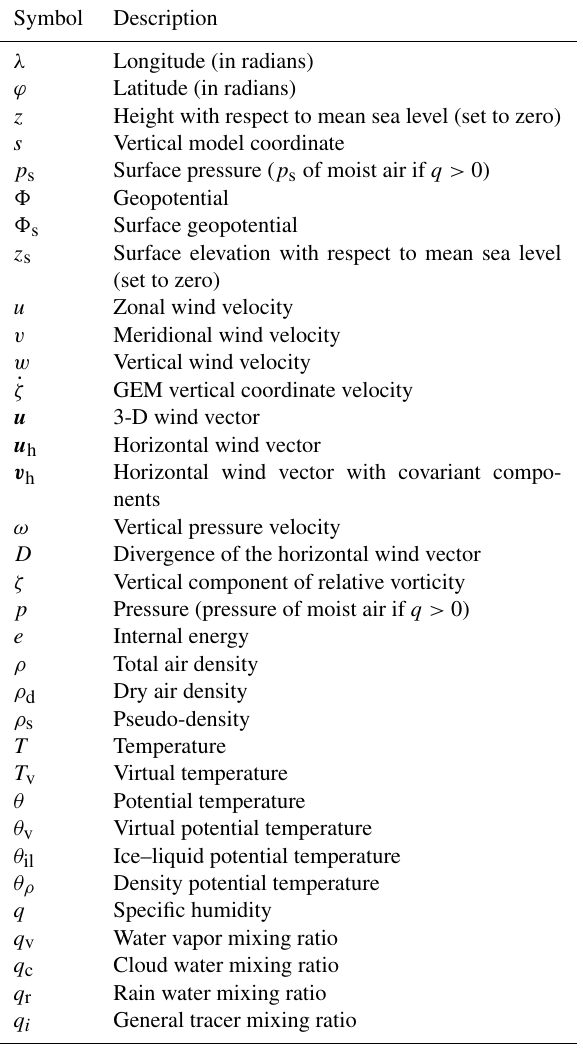
Table 1. A standard list of symbols used throughout this paper and in the